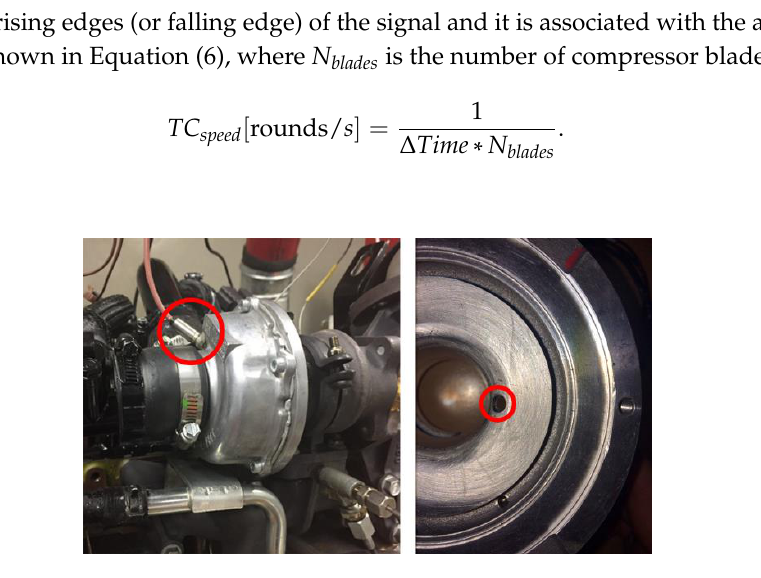
Figure 6. Hall effect sensor installed on the compressor case. Figure 6. Hall e ff ect sensor installed on the compressor case. Energies 2019 , 12 , x FOR PEER REVIEW